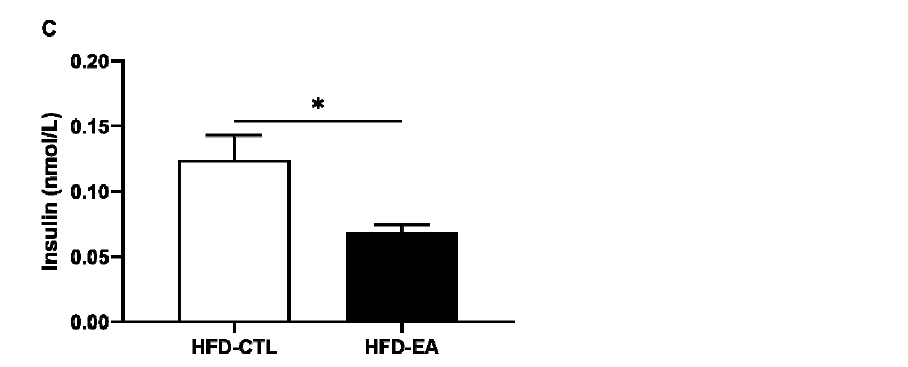
Figure 1. Effect of ellagic acid supplementation on blood glucose levels during ( a ) oral glucose tolerance test, ( b ) area under the curve (AUC), and ( c ) insulin levels. Values are mean ± SEM, n = 8/group. The significance levels for comparison between control (HFD-CTL; high-fat diet-fed rats) and experimental (HFD-EA; high-fat diet-fed rats supplemented with ellagic acid) groups are indicated as follows: * p < 0.05, ** p < 0.01.